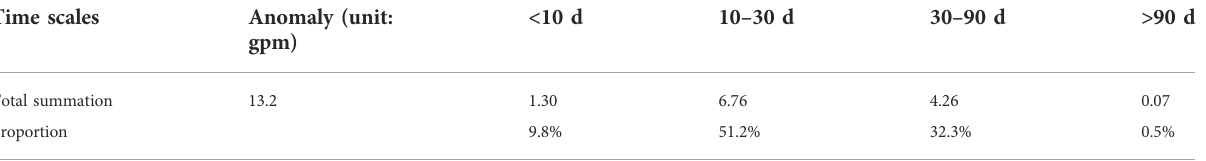
TABLE 3 Contribution of different time-scale anomalies in the lower-latitude key